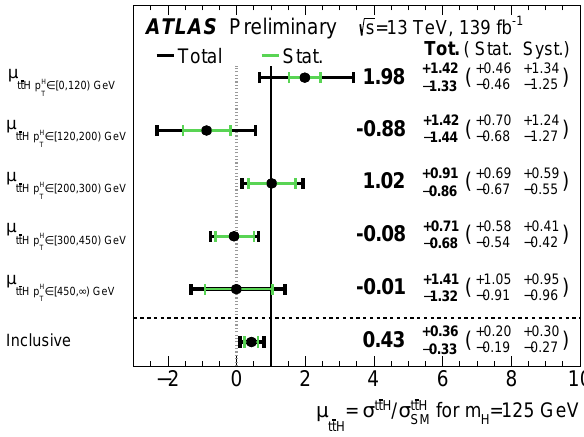
Figure 3: Measured signal strength for ttH signals in each STXS bins, as well as the inclusive signal strength [ 17 ]